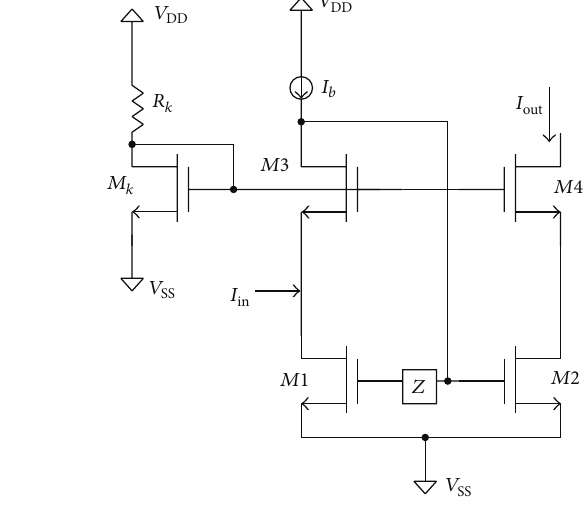
Figure 4: Compensated LVCCM.